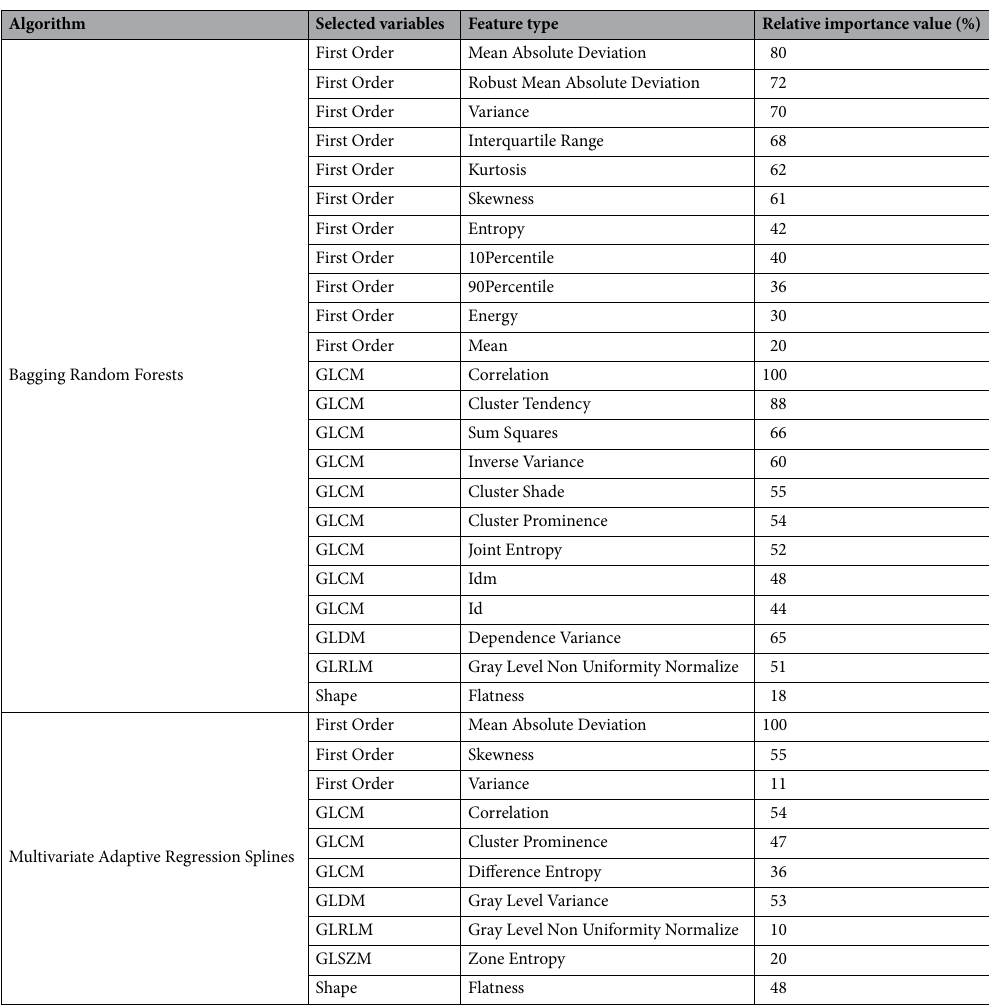
Table 1. Selected features by Bagging Random Forests (“VSURF” R package) and multivariate adaptive regression splines (“earth” R package) for multi-class classification using nested fivefold cross validation based on the training set (50% of the samples, N = 555) and the validation set (20% of the samples, N = 223). Relative importance value calculated using generalized cross-validation (GCV) criterion with